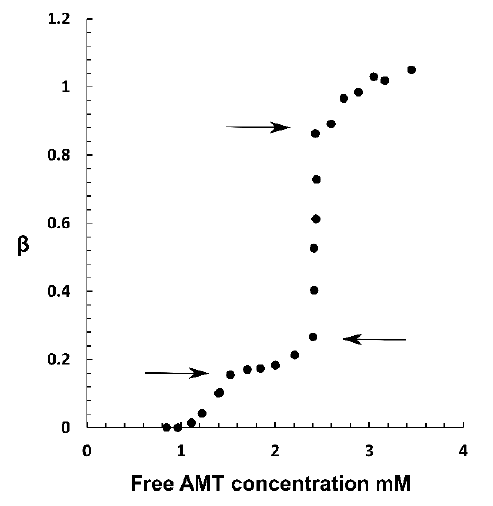
Figure 9. Binding isotherms of AMT in polyacrylate microgels at 155 mM ionic strength. Binding ratio plotted vs. AMT free concentration, which represents the equilibrium concentration of AMT in the liquid. Arrows mark the transitions between different regimes.